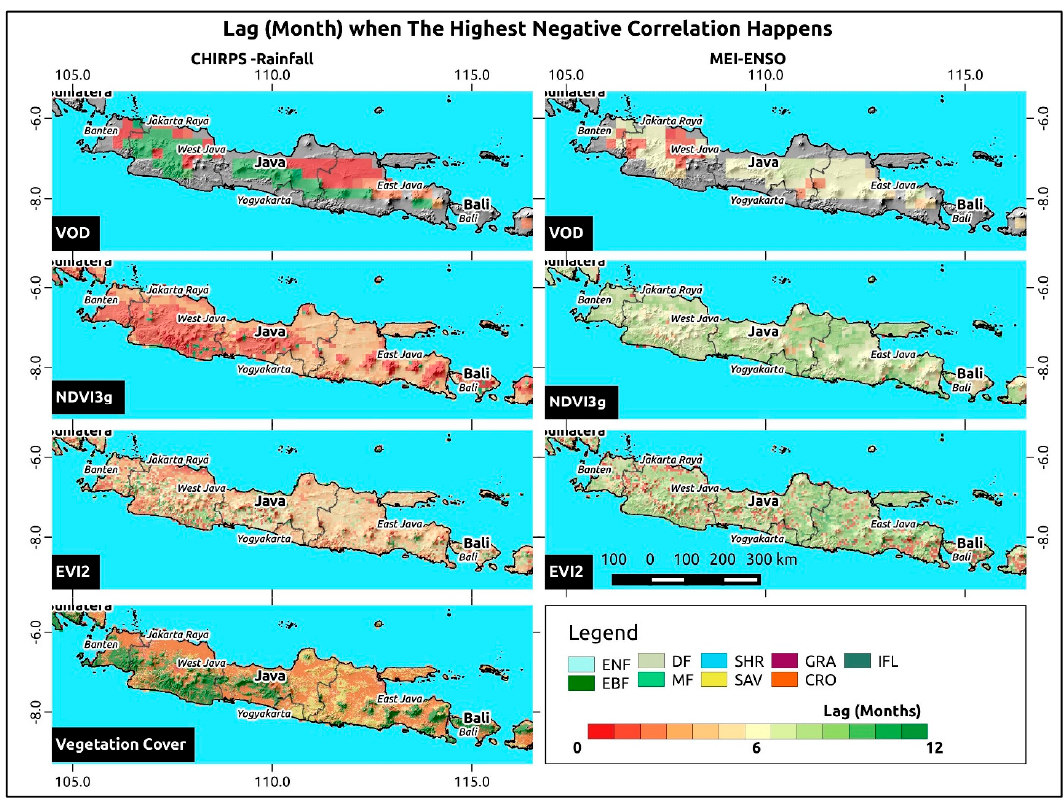
Figure 11. Distribution of lag time of significant negative CCF correlations of MEI to RS proxies and CHIRPS to RS proxies indicating that topography can affect lag distribution.